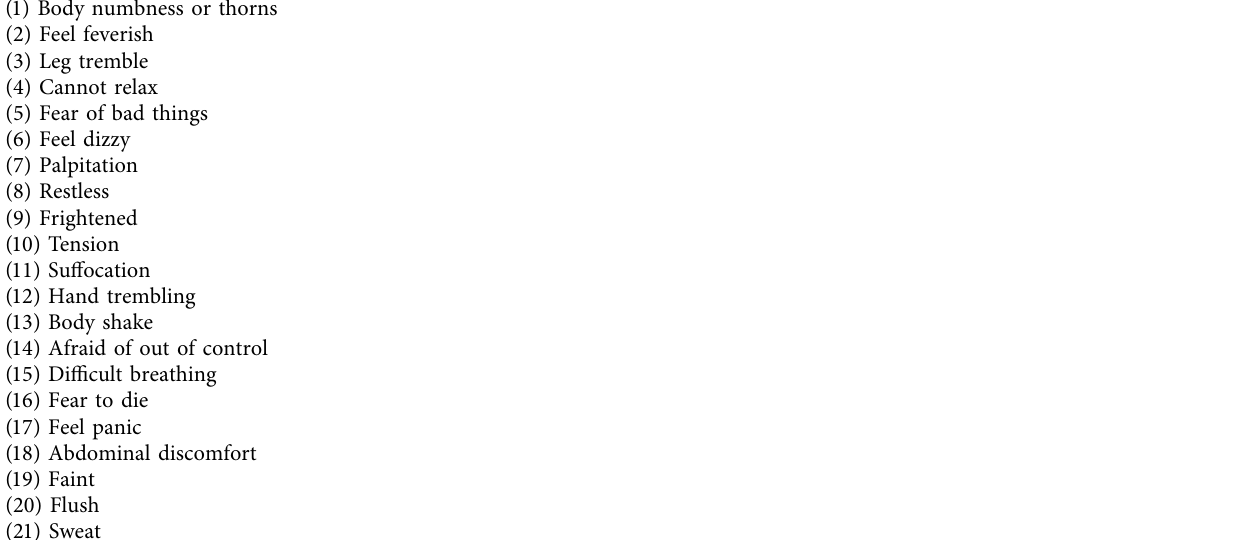
Table 2: Beck anxiety inventory (BAI).